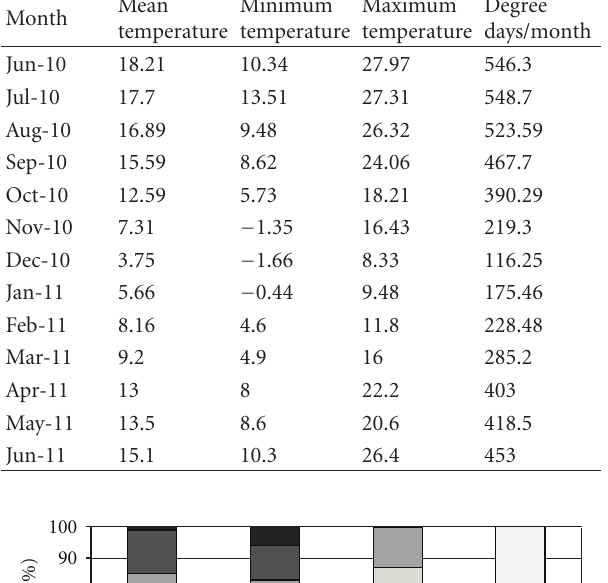
Table 1: The mean, minimum, and maximum monthly water tem- peratures and degree days per month, recorded by a continuous temperature monitor in Bannow Bay from June 2010 to June 2011.